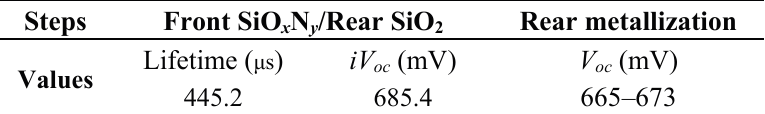
Figure 5. Test sample before rear contact patterning ( left ), PERC rear contact with Al metallization ( right ). Table 7. Lifetime, iV oc and V oc change of test structures before and after rear surface